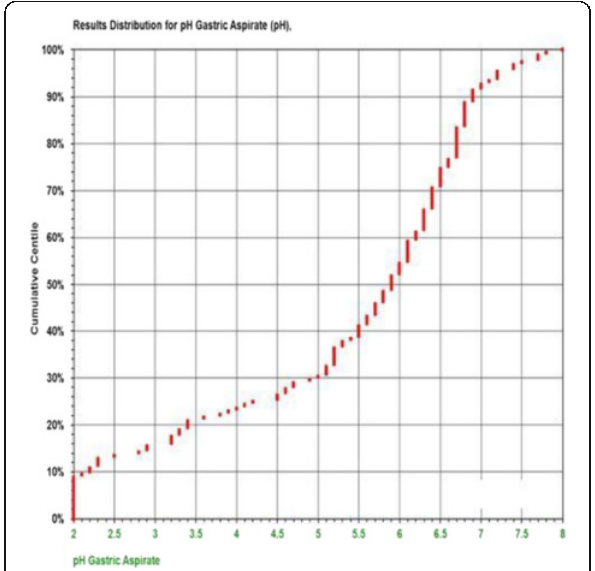
Fig. 103 (abstract A253). Results distribution for gastric aspirate (pH)